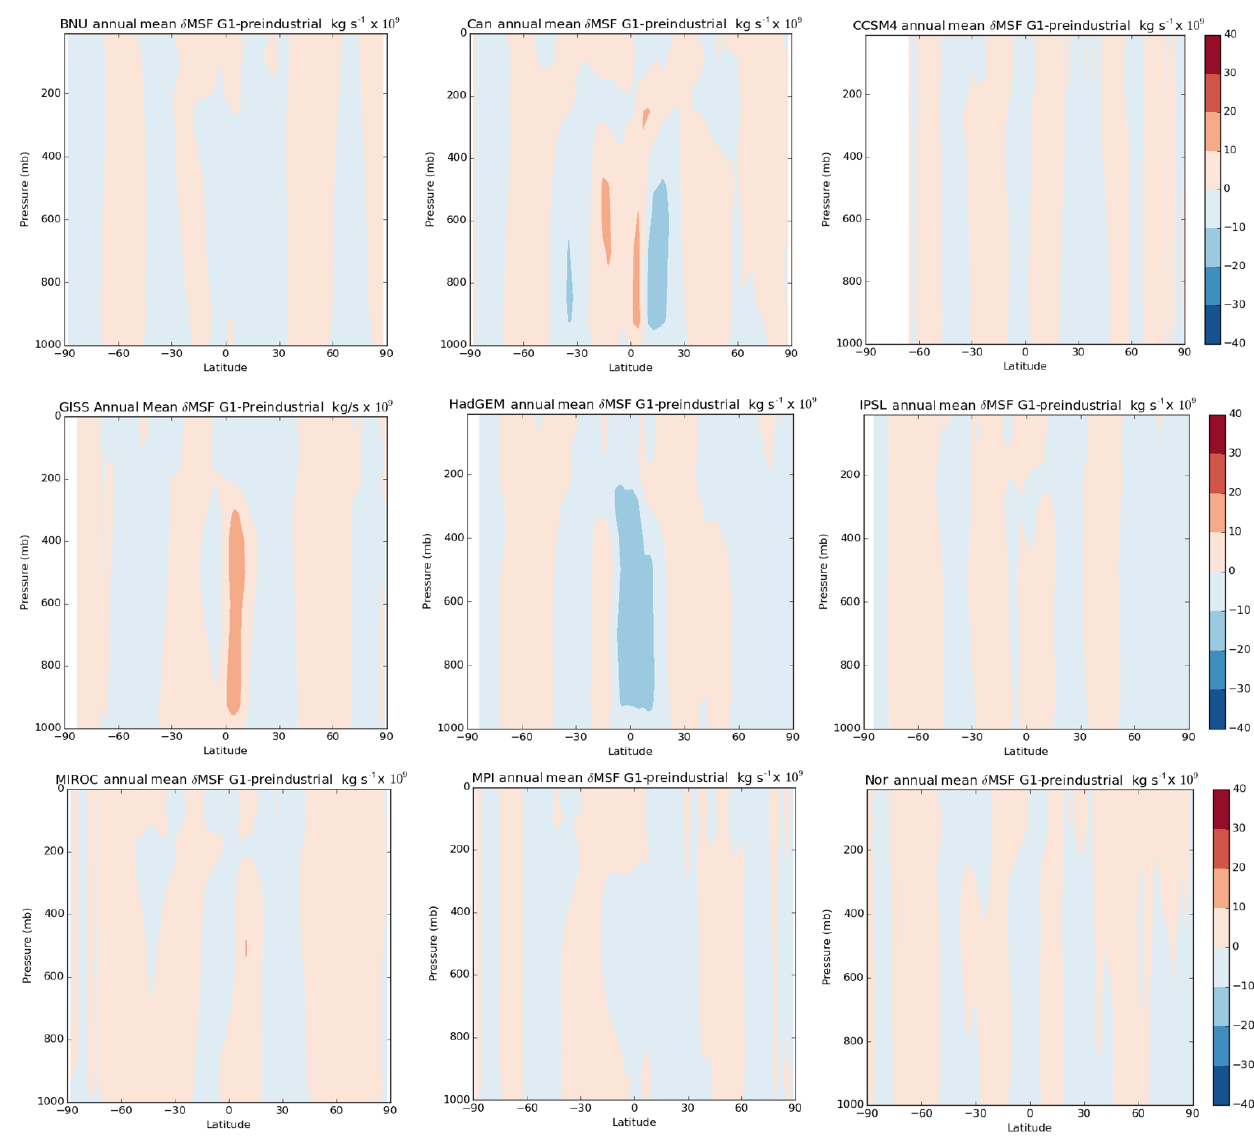
Figure 6. The annual mean meridional stream function anomaly between G1 (years 11–50) and piControl (last 40 years) in each model, as calculated in Eq. (4). The blue coloring indicates counterclockwise motion (data unavailable for HadC and CESM